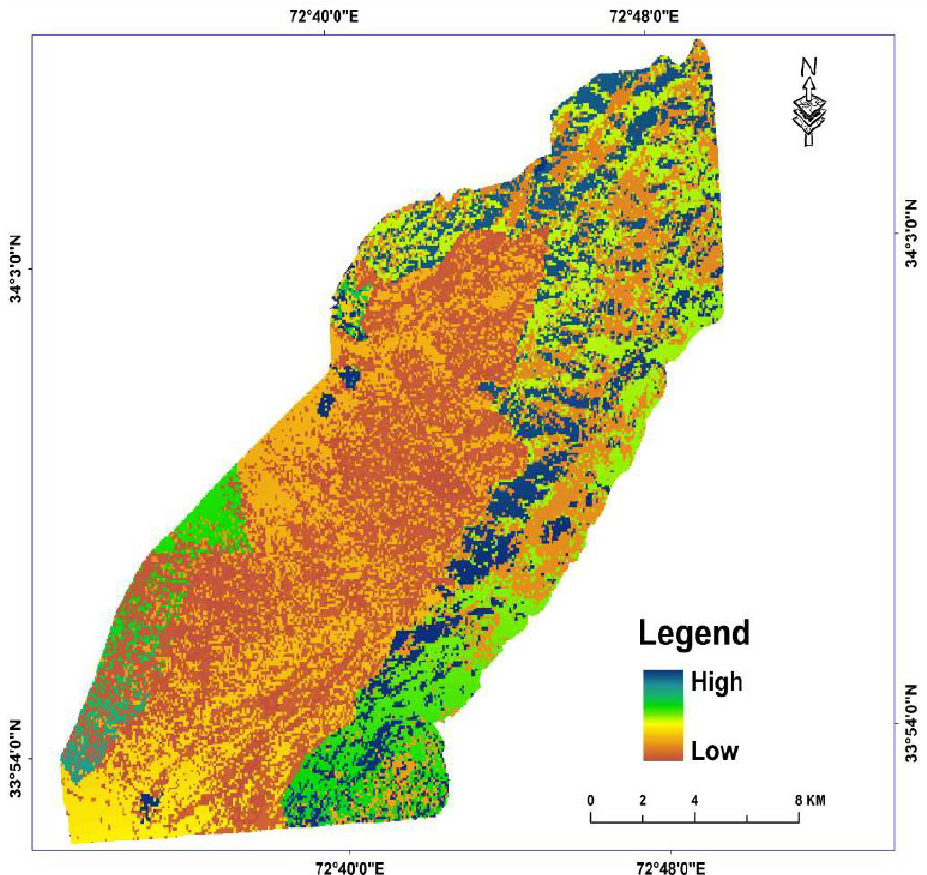
Figure 8. Runoff potential distribution in the study area.